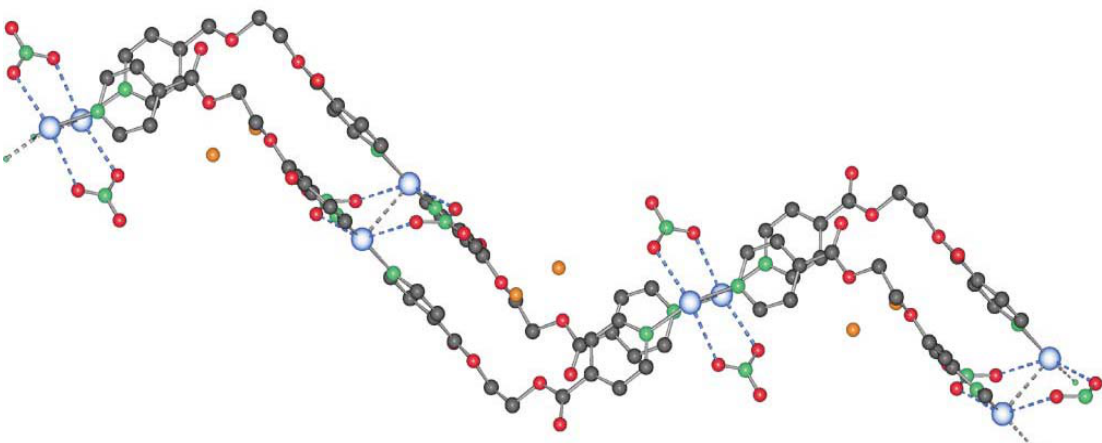
Figure 4. Double-chain structure of compound 5 (same color code as